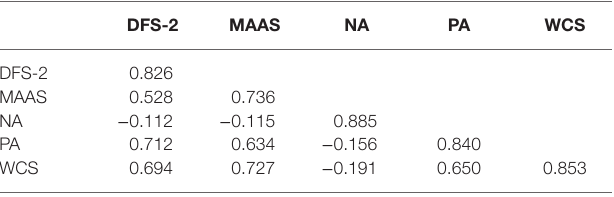
TABLE 5 | Inter-construct correlations and discriminant validity.